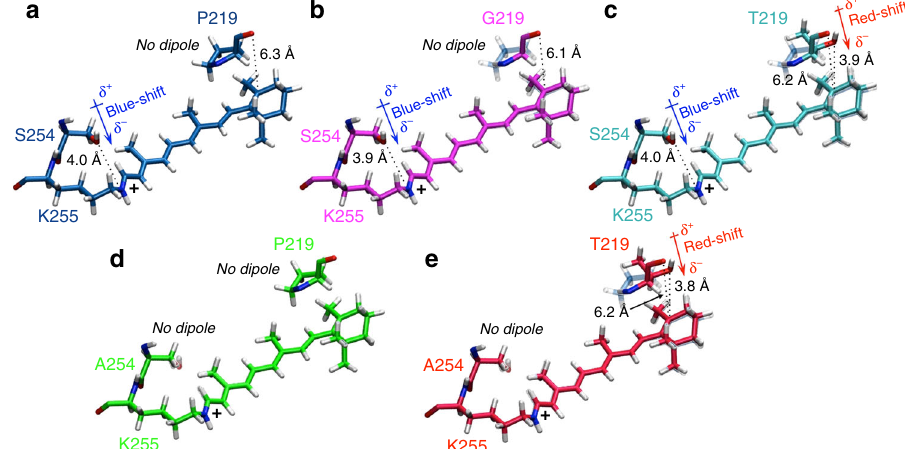
Fig. 6 Quantum mechanics/molecular mechanics structures around retinal chromophore in KR2 wildtype (WT) and mutants. Comparison between retinal chromophores and mutated residues 219 and 254 in a KR2 WT, b P219G, c P219T, d S254A and e P219T/S254A mutants. For mutants are also shown, in transparent representation, the retinal chromophore and 219 and 254 residues of